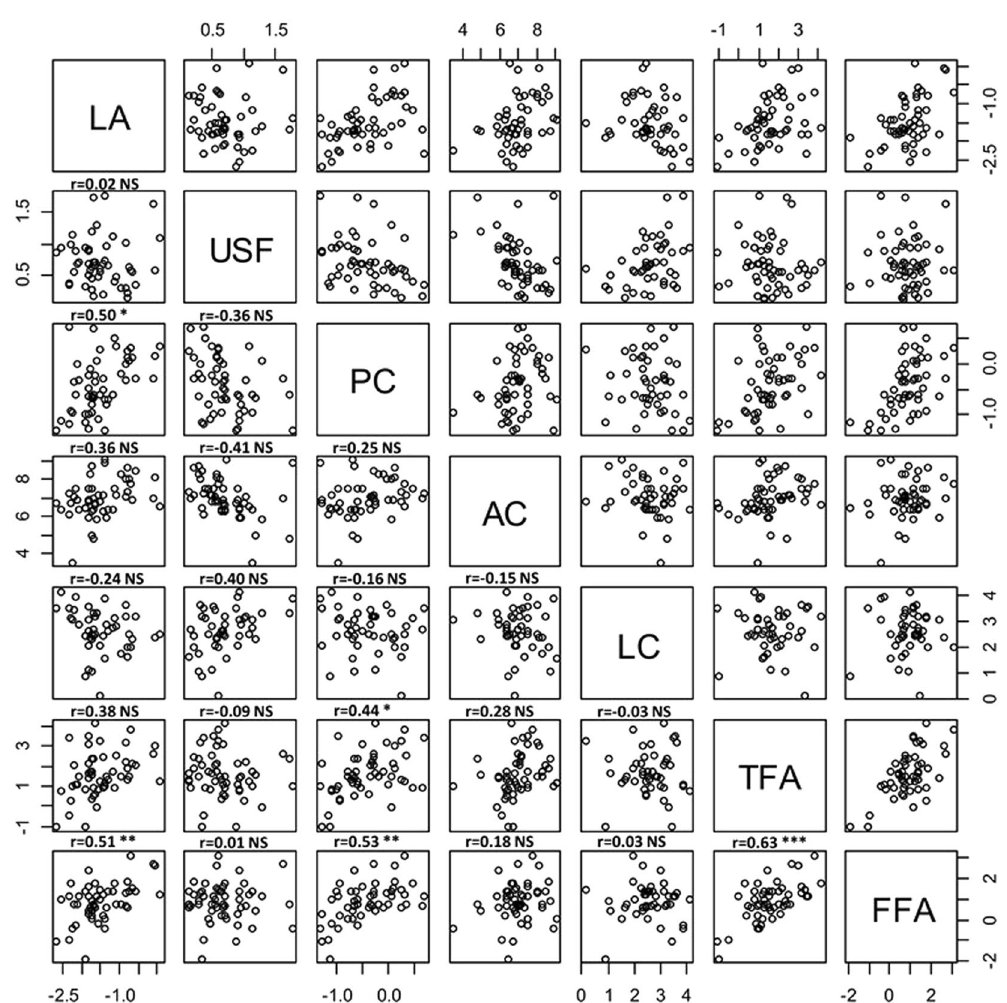
Figure 3. Scatterplot matrix of the different salivary variables (LA, Lipolytic Activity; USF, Unstimulated Salivary Flow; PC, Protein Concentration; AC, Antioxidant Capacity; LC, Lipocalin Concentration; TFA, Total Fatty Acids concentration; FFA, Free Fatty Acids concentration). Logarithmic transformations were applied to all variables except USF to deal with skewed data. Pearson coefficient is reported when adjusted p value (Bonferroni) is significant. NS: Non Significant; * p < 0.05; ** p < 0.01; *** p <